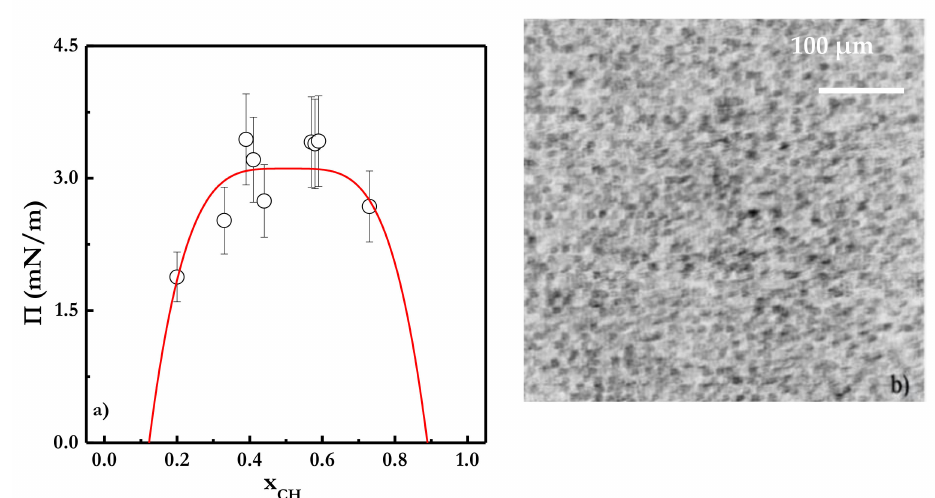
Figure 6. ( a ) Coexistence surface pressure-cholesterol molar fraction diagram for Langmuir monolayers of mixtures of CH and CE spread at the water/vapor interface at 24 ◦ C. The symbols are the experimental data and the line represents the theoretical prediction according to Equation (10). ( b ) Brewster Angle Microscopy image (320 × 320 µ m 2 ) for the coexistence surface pressure for a Langmuir monolayer of a mixture of CH and CE spread at the water/vapor interface with x CH = 0.44 at 24 ◦